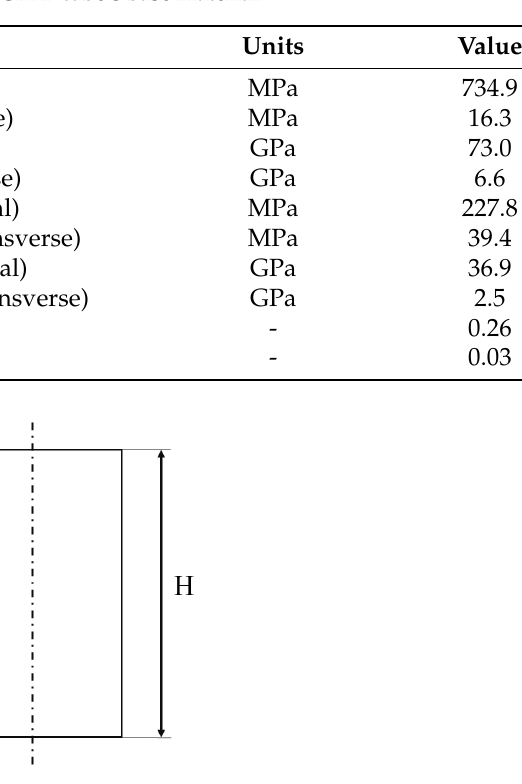
Figure 4. Parameters defining the topology of the hollow composite tube. Table 3. Hollow composite tube design